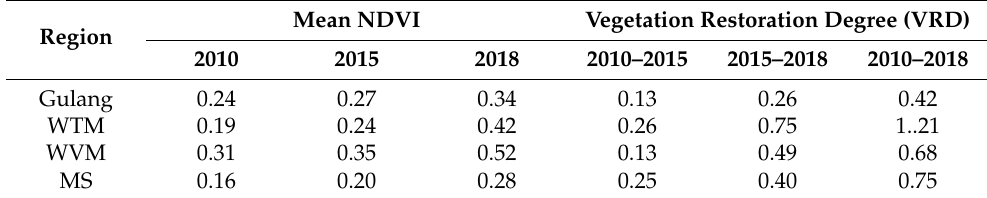
Table 3. Changes in NDVI average and vegetation restoration degree, 2010–2018. Mean NDVI Vegetation Restoration Degree (VRD) Region